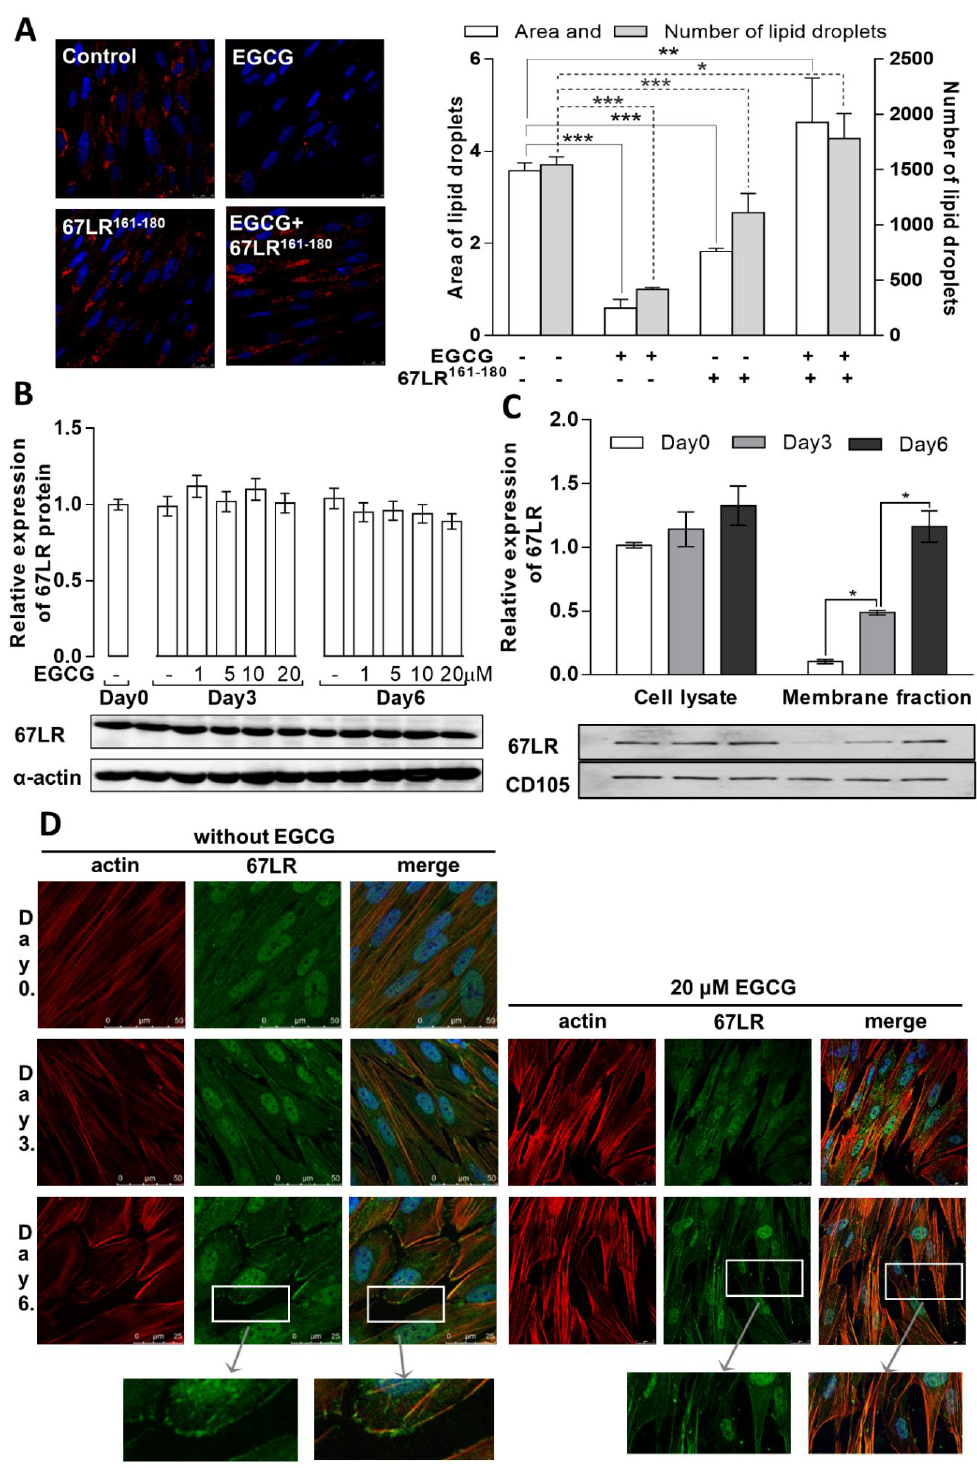
Figure 2. The effects of an EGCG-binding 67LR peptide (67LR 161-180 ) and EGCG on lipid droplet formation, and expression and localization of 67LR in differentiating MSCs. ( A ) The effects of EGCG (20 µM), 67LR 161-180 (20 µM), or EGCG (20 µM) plus 67LR 161-180 (20 µM) on lipid droplet (red) formation on day 6 of the adipogenic differentiation of MSCs (left panel) and ImageJ analyses of the area and number of droplets (right panel, n = 5). Treatments were compared with two-way ANOVA; * p < 0.05, ** p < 0.01, *** p < 0.001. ( B ) MSCs were differentiated in the absence or presence of 1, 5,